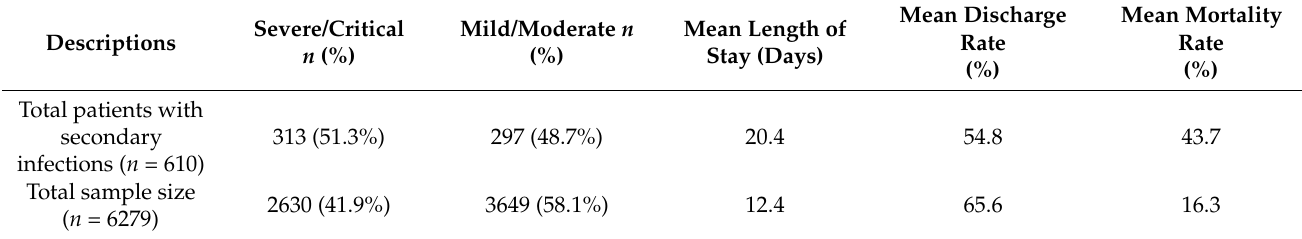
Table 6. Secondary infections and health